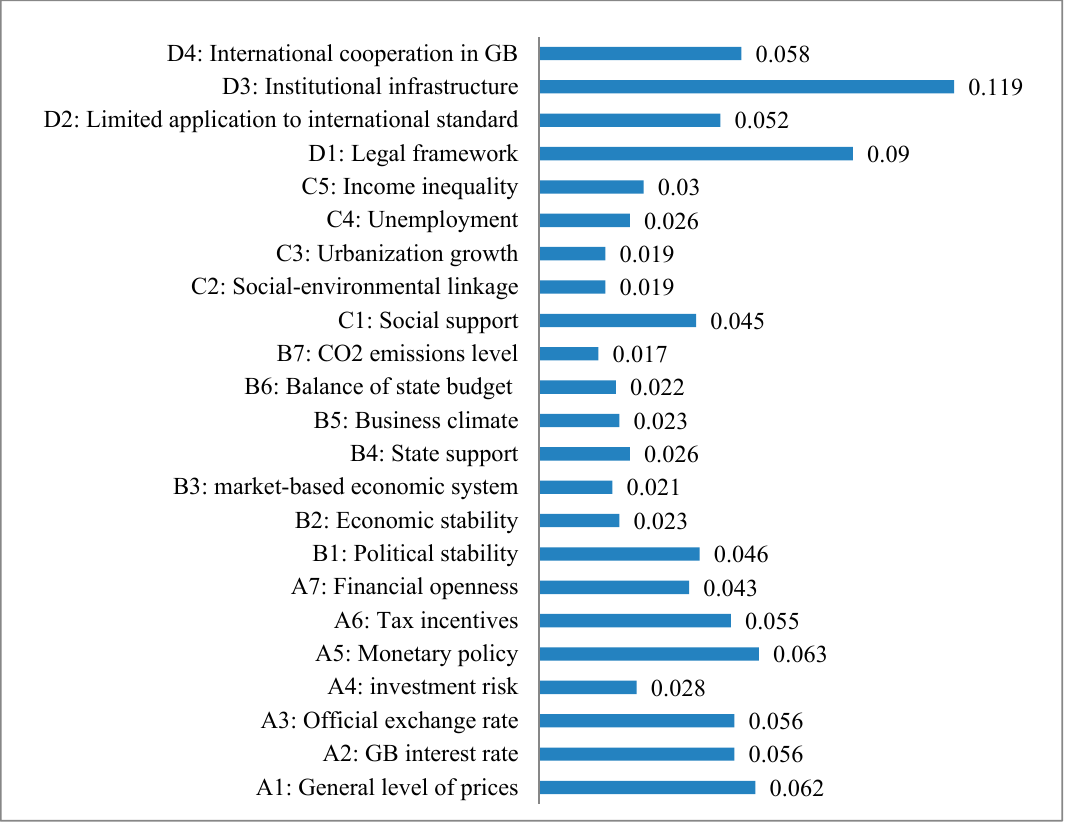
Figure 1. Overall weights of sub-criteria with respect to the goal. Note: consistency index is 0.01. Source: Export Choice output. GB, green bond.